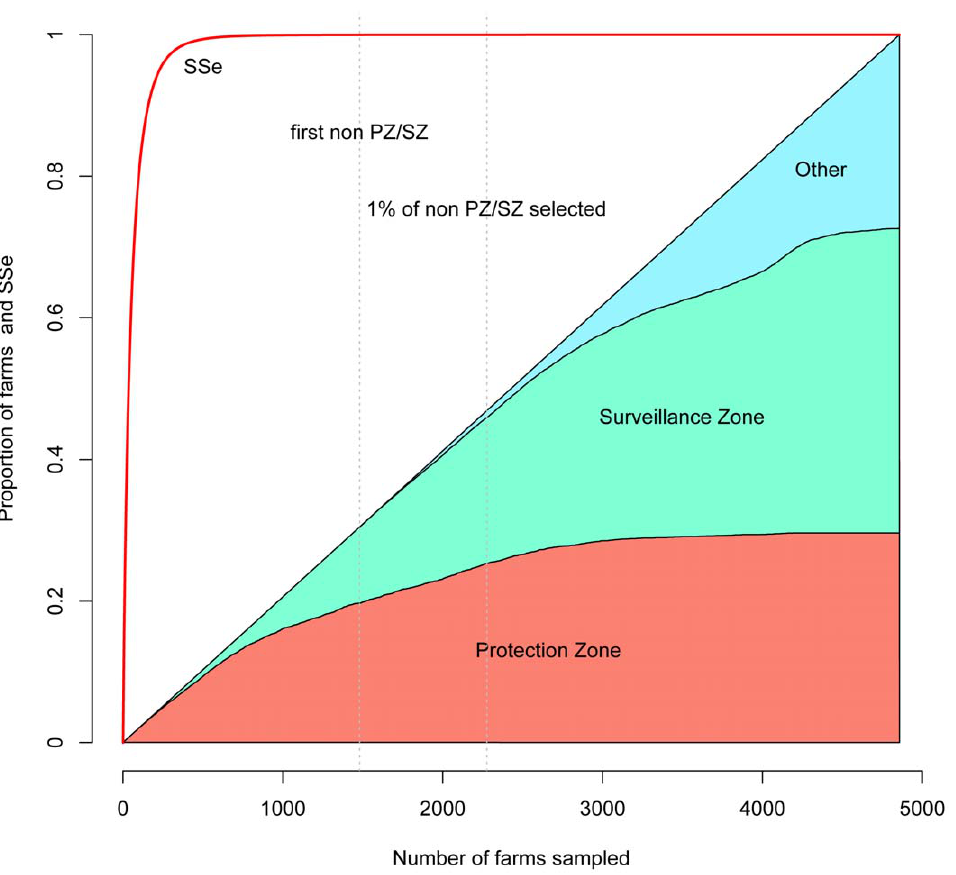
Figure 3. Risk-targeted sampling and traditional surveillance zones. Source zone of farms when the farms are allocated in decreasing probability of undiscovered infection. Vertical dotted lines showing points at which first and first 1% of farms outside the surveillance zone (SZ – a 3– 10 Km buffer around designated infected premises) and the protection zone (PZ – a 3 Km buffer around designated infected premises) will be selected. The red line shows the estimated system sensitivity (SSe) using risk-targeted selection for the range of sample